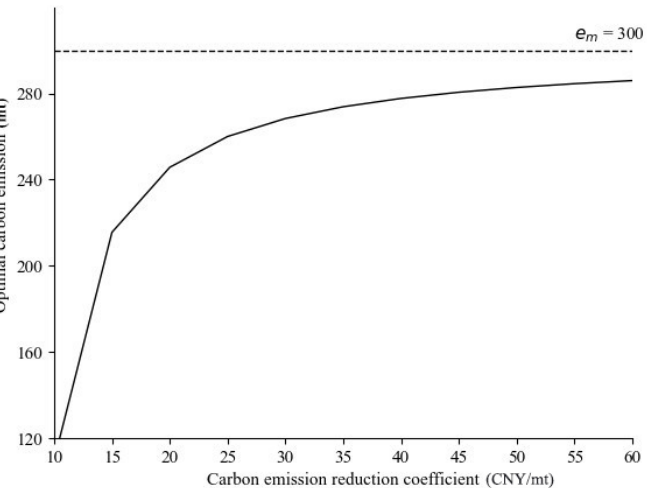
Figure 4. Influence of the carbon emission reduction coefficient on optimal carbon emission reduction.